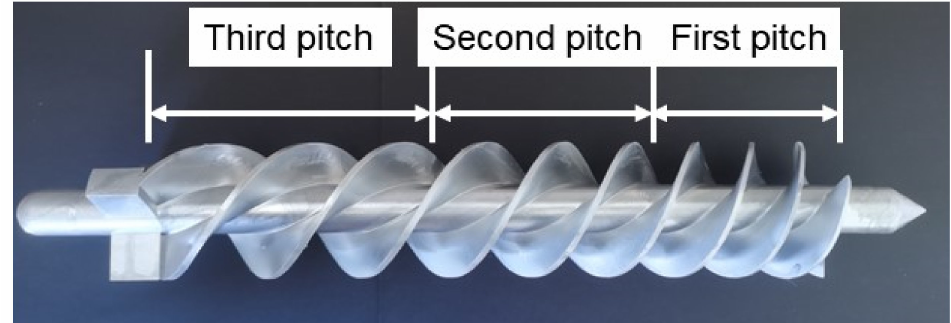
Figure 6. Schematic diagram of the optimized helical blade of the cyclone